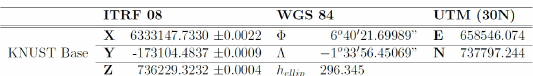
Table 1: Base Station Coordinates